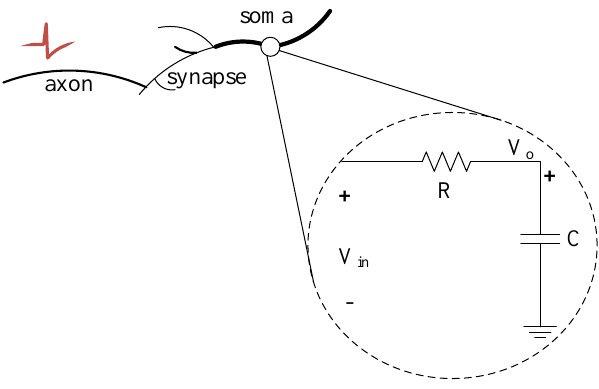
Figure 3. RC circuit filter and its relation/analogy to the